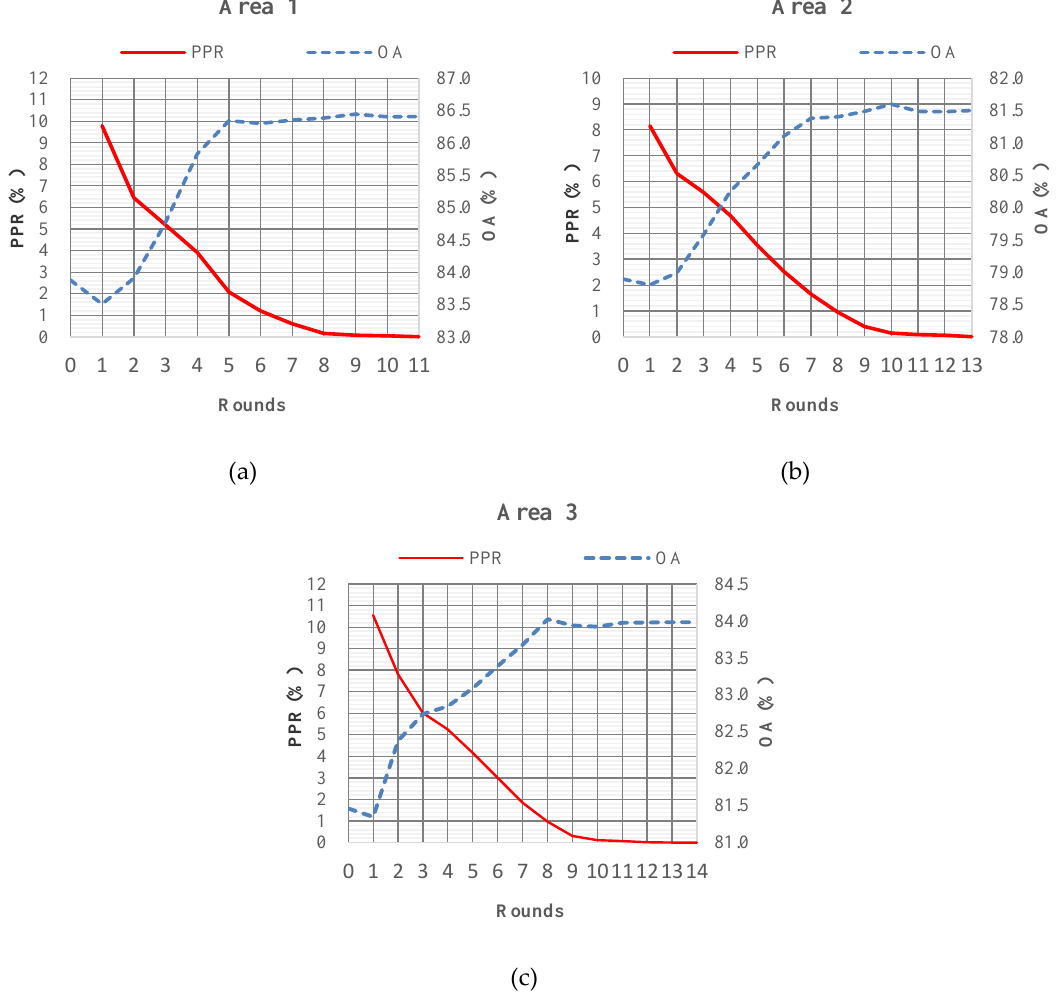
Table 4. Computation time of the proposed method in three Vaihingen sites.